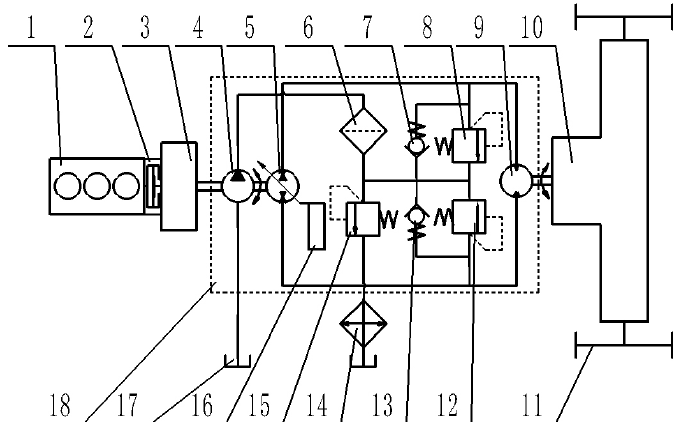
Figure 1. Sketch of the structure of the drive system of the hillside crawler tractor. 1. Engine; 2.